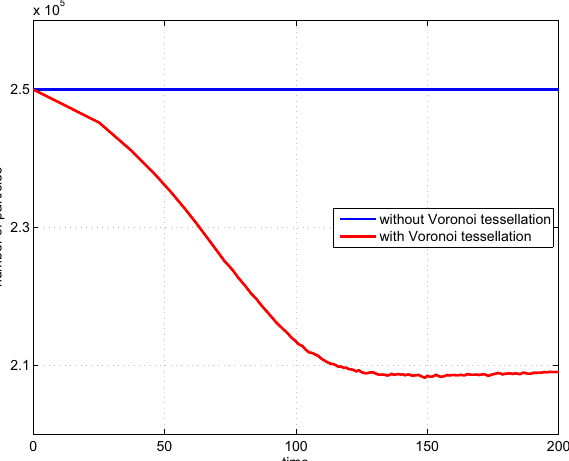
Figure 35. Number of Lagrangian particles as a function of time when Voronoi tessellation algorithm is